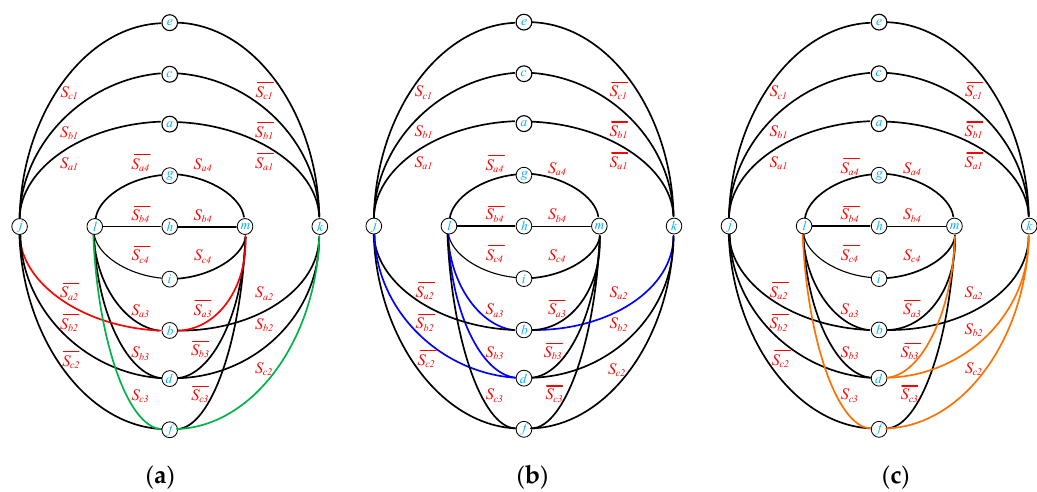
Figure 4. Graphs for CHB-SDC short-circuit states analysis: ( a ) C DC 1 and C DC 2 in short-circuit [9]; ( b ) C DC 1 in short-circuit; ( c ) C DC 2 in short-circuit.